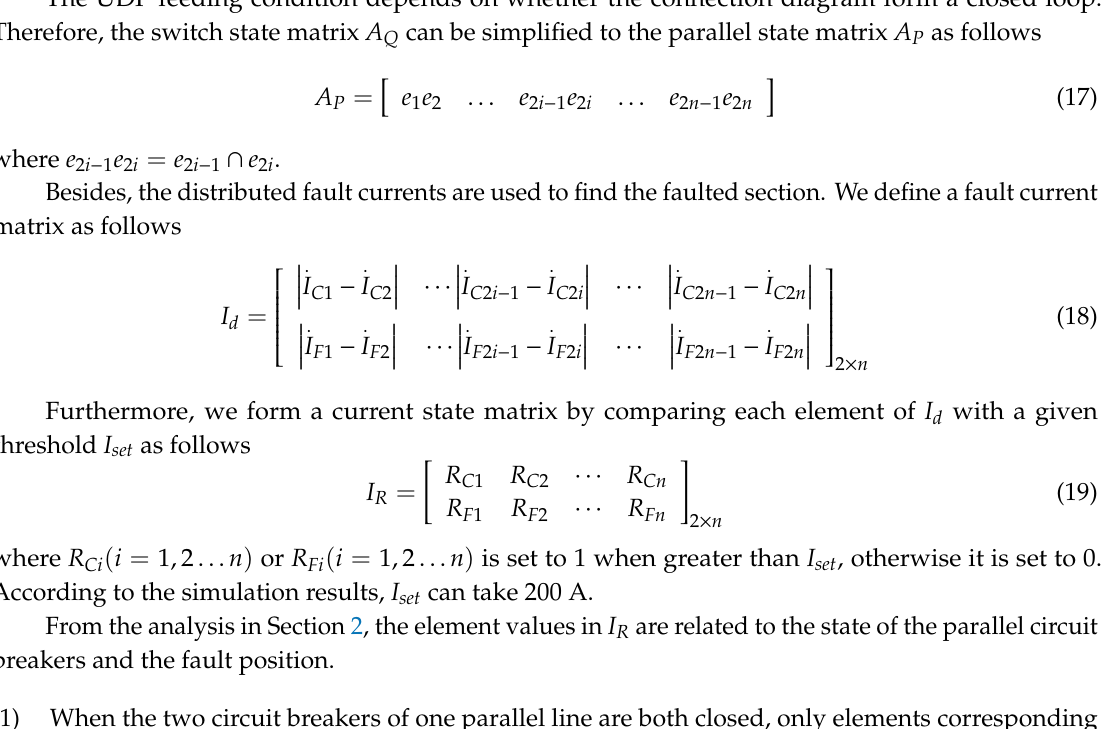
Table 1. Indication of two